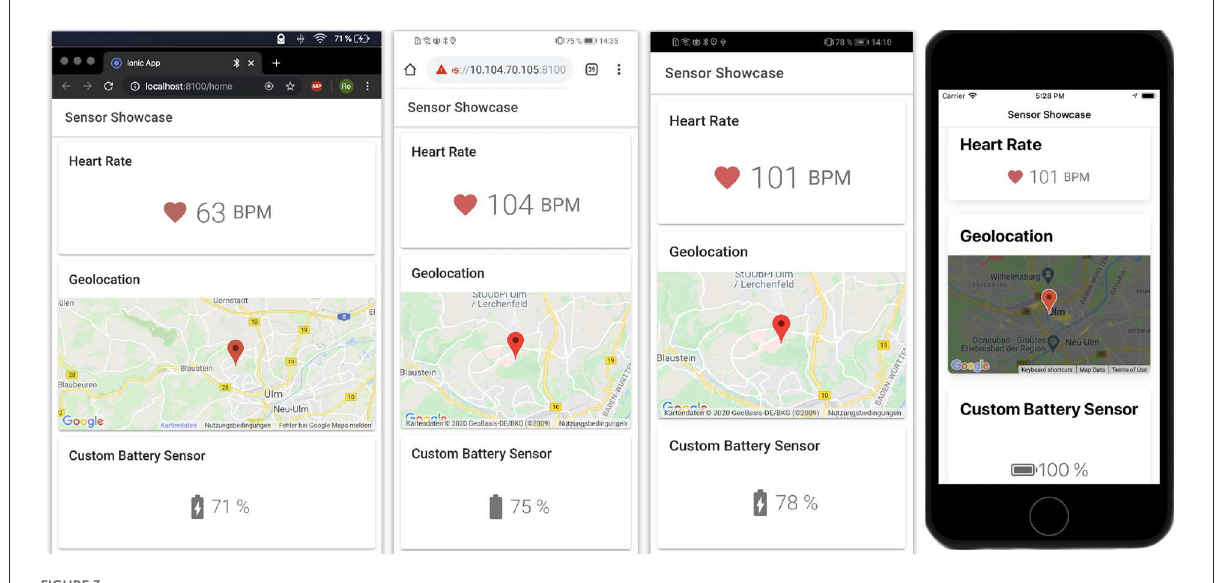
FIGURE3 Resulting application running on different platforms. From left to right: Web Application on Google Chrome, Web Application on Chrome for Android, Native Android Application, and Native iOS